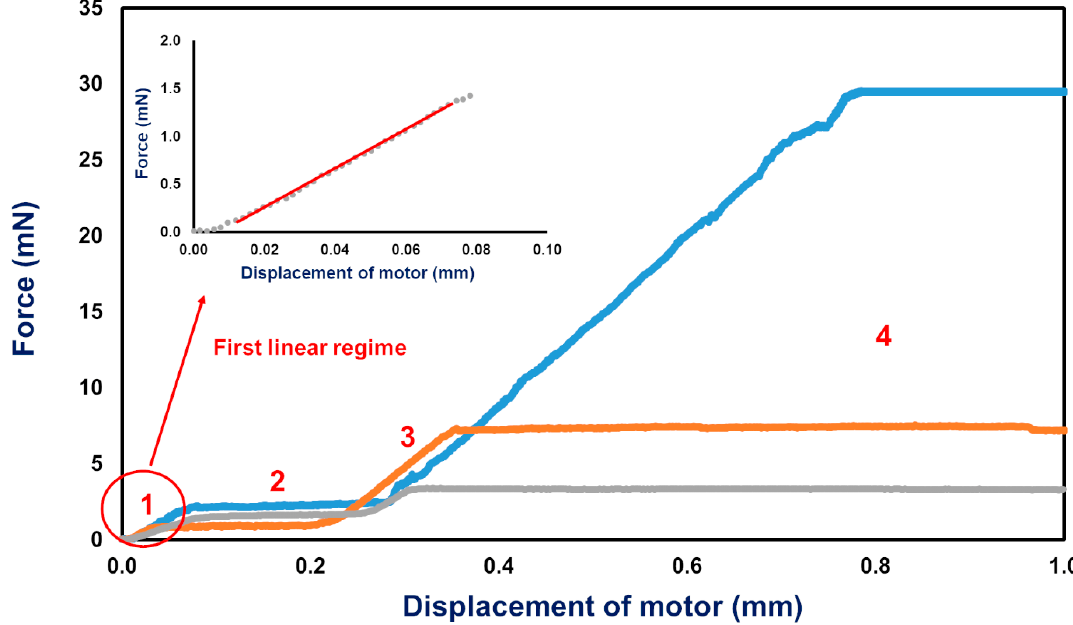
Figure 2. Force-Displacement curves of three individual retina stretching experiments with different stretching velocities: 0.1 µm/s (blue), 0.5 µm/s (orange), and 2.0 µm/s (grey). The inset shows the magnification of the FD curve for small displacements for a displacement rate of 2.0 µm/s. The FD curves display four different regimes: ( 1 ) A linear force increase for small displacements; ( 2 ) yielding and plastic deformation at constant force; ( 3 ) a second force increase for larger displacements followed by ( 4 ) another constant force plateau.